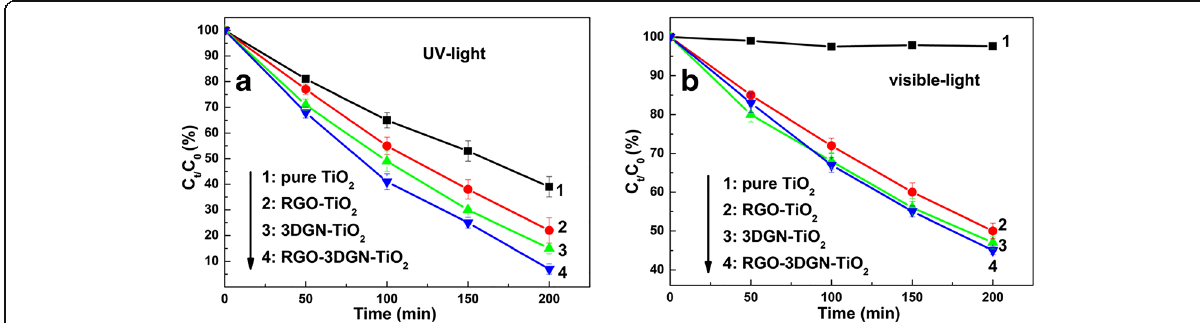
Fig. 2 Decomposition experiments of phenol under a UV-light and b visible-light irradiation